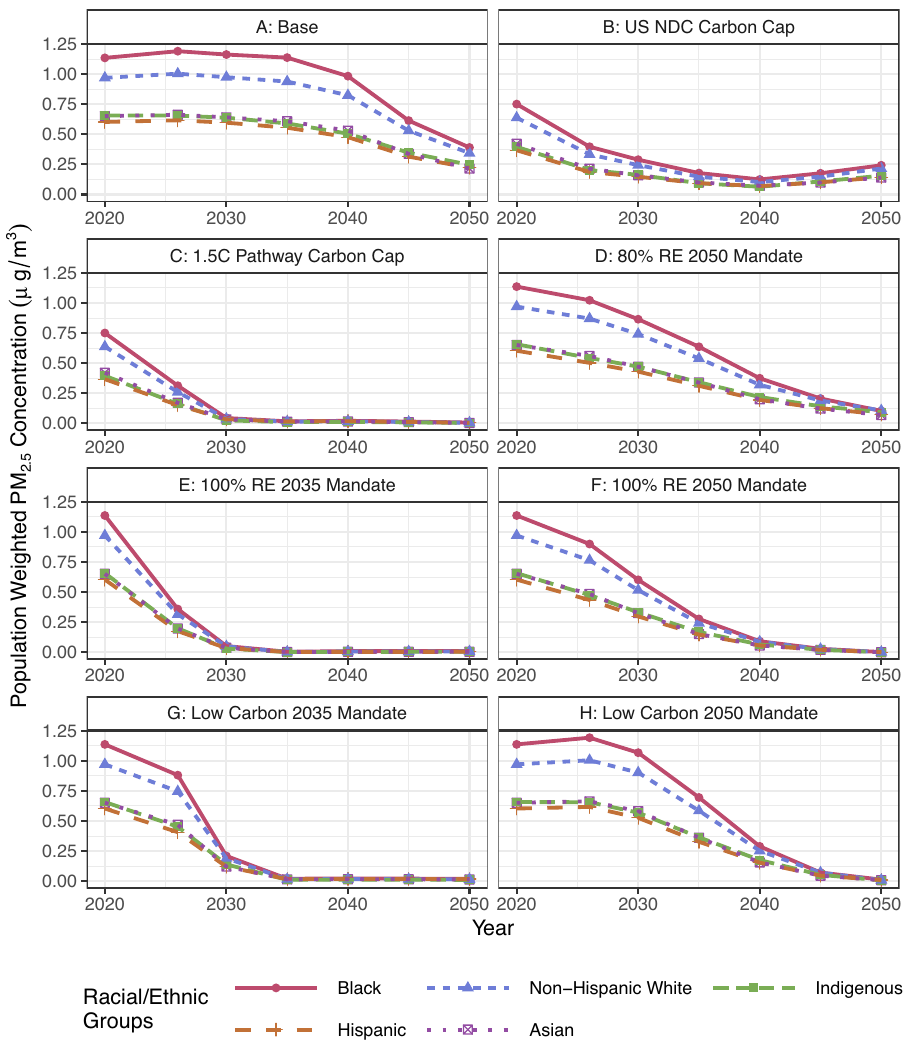
Fig. 4 | Population weighted average annual PM 2.5 concentrations (in µ g/m 3 ) across different race and ethnicity groups for each scenario from 2020 to 2050. We see that Black communities in the US are exposed to higher concentra- tionsofPM 2.5 in2020,whichisconsistentwithhistoricalimpacts 28 .Overtheenergy transition,BlackcommunitiesareexposedtohigherconcentrationsofPM 2.5